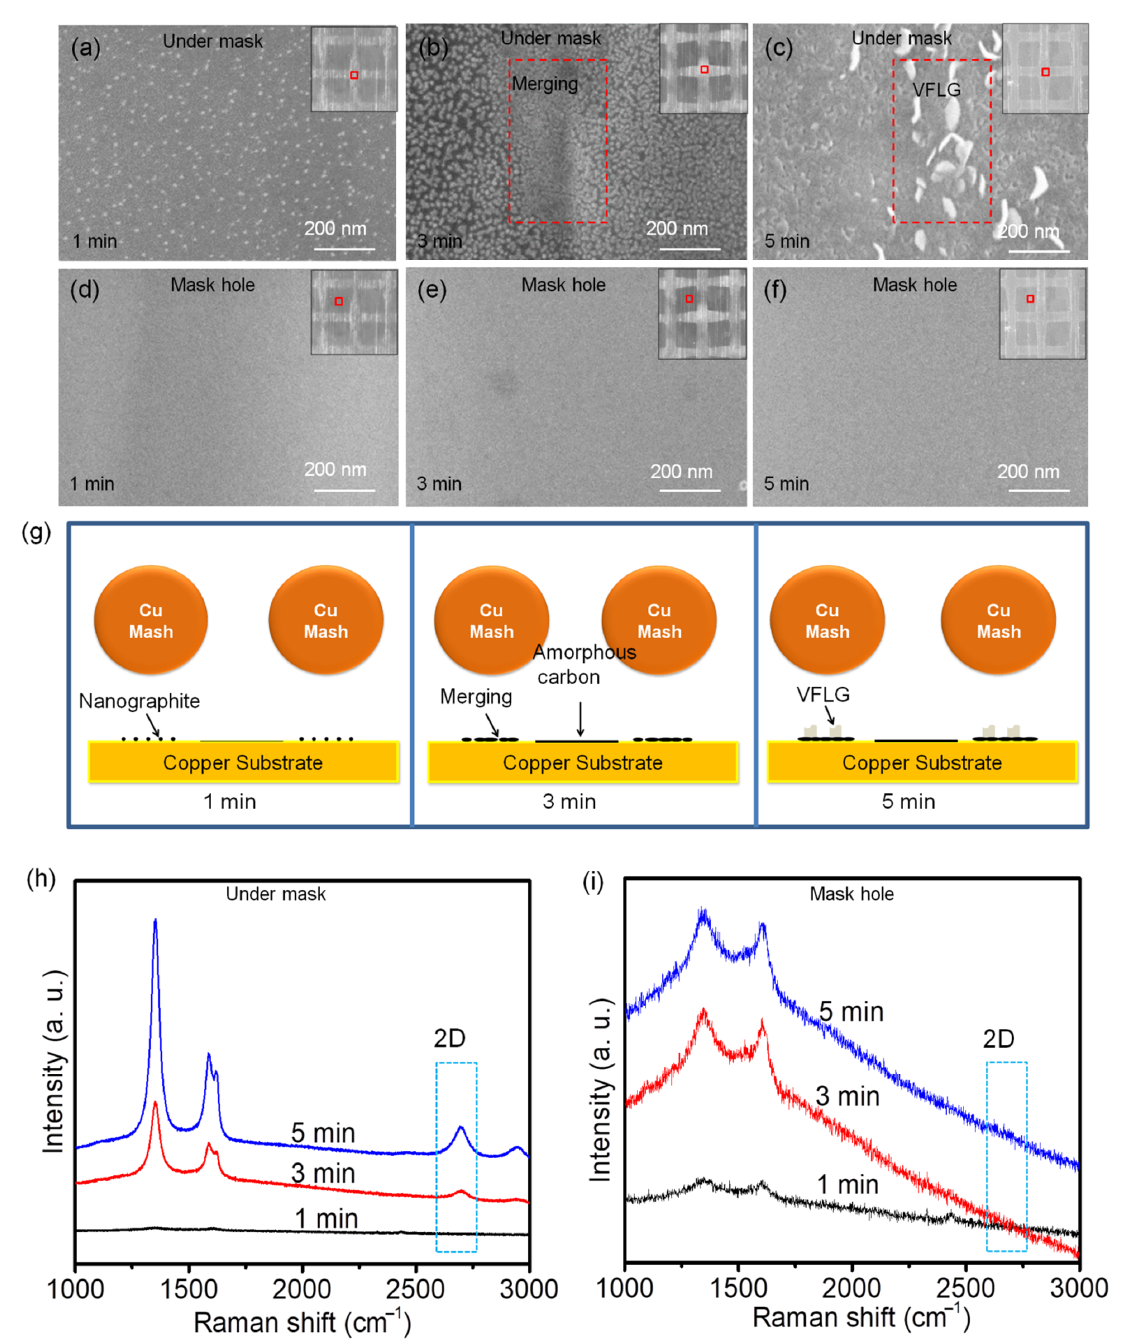
Figure 3. SEM images of VFLG grown with Cu mask in various time; ( a , d ) 1 min; ( b , e ) 3 min; ( c , f ) 5 min. ( g ) Schematic diagrams of VFLG grown 1 min, 3 min, and 5 min; ( h ) Raman spectra of VFLG grown under Cu mask; ( i ) Raman spectra of VFLG grown at Cu mask hole. Inset pictures of ( a – f ) show the position of SEM images.